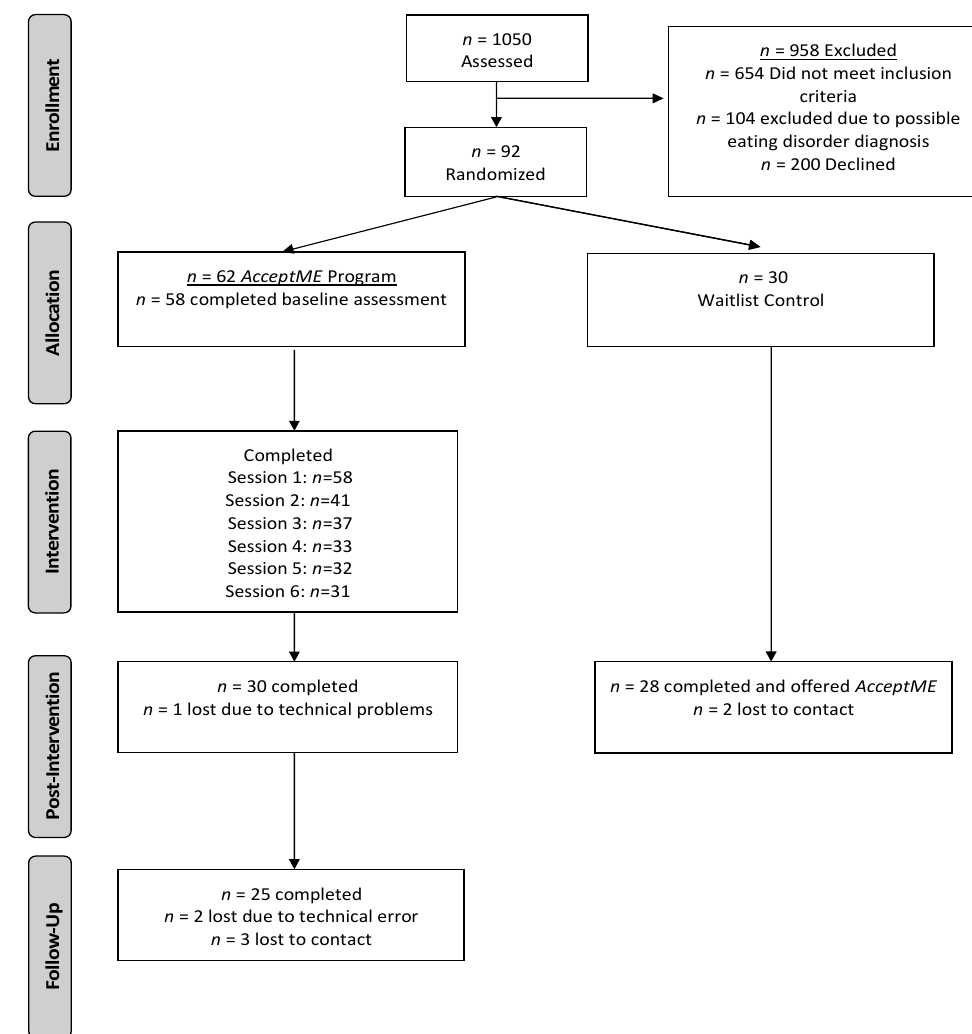
Figure 1. CONSORT flow diagram.